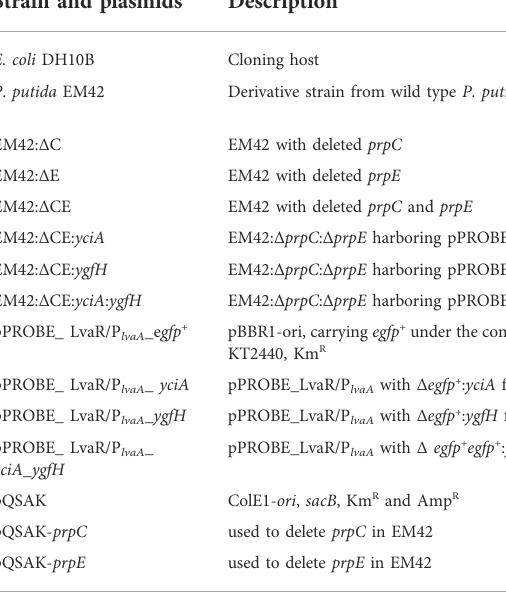
TABLE 1 Strains and plasmids used in this